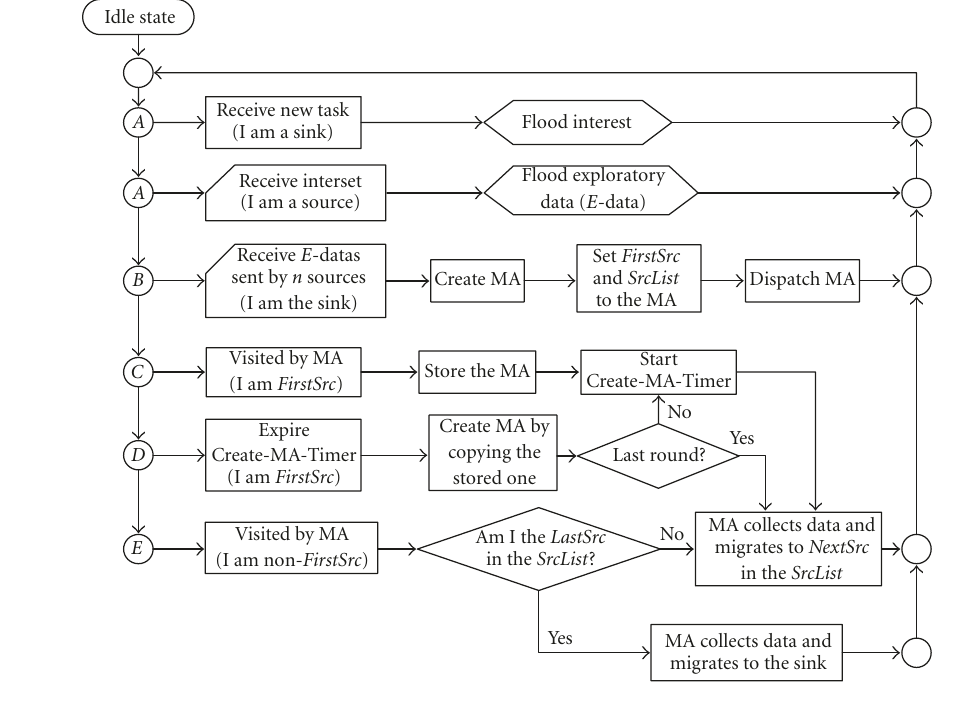
Figure 3: Flowchart of the basic MADD protocol.